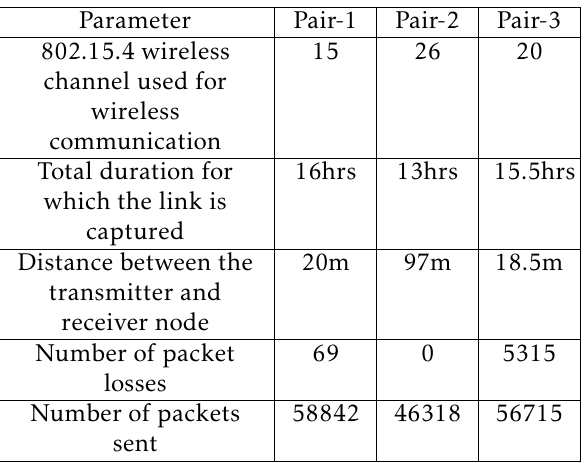
Table 1. Properties of the links analyzed Parameter Pair-1 Pair-2